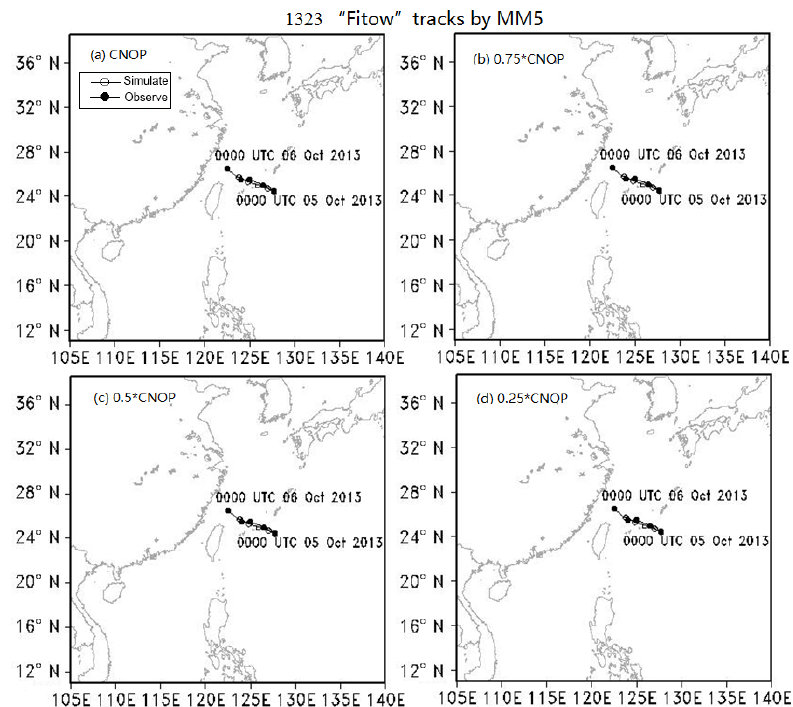
Figure 15. Simulated TC tracks from MM5 through the insertion of the CNOPs or W × CNOP into the initial state in the entire domain for TC Fitow. Solid circles represent the observed TC tracks from the CMA, and the hollow circles show the simulated TC tracks from the MM5 model. Letters (a) , (b) , (c) and (d) denote the CNOP, 0.75 × CNOP, 0.5 × CNOP and 0.25 × CNOP results, respectively.